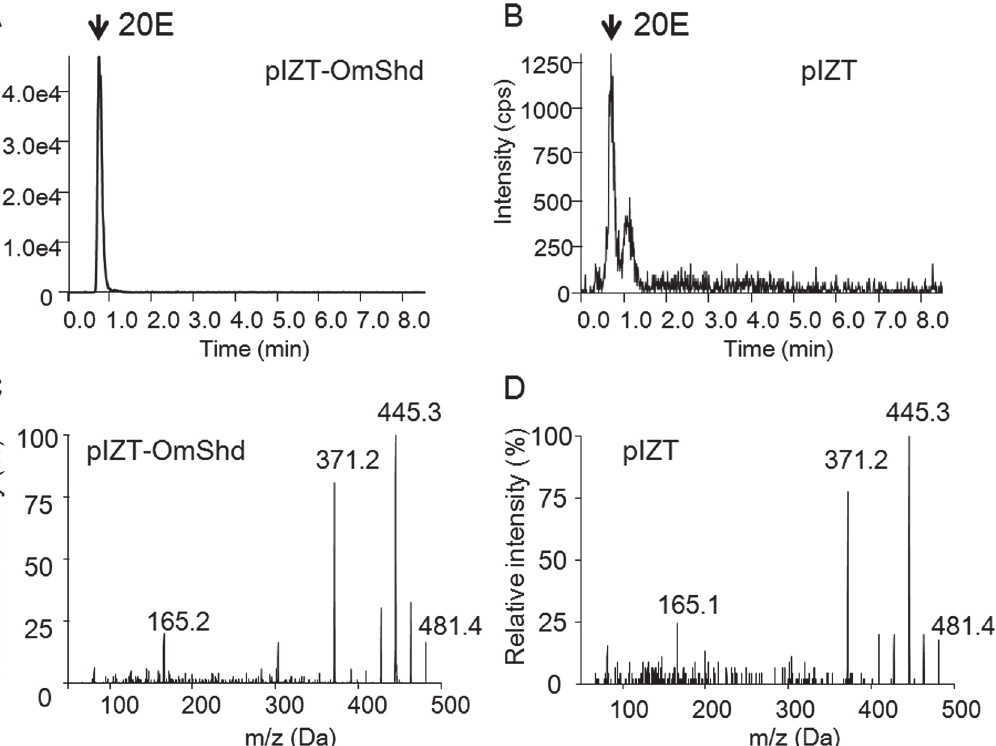
Fig 4. Chromatograms of 20-hydroxyecdysone (20E), produced by enzymatic assay of OmShd, analyzed with LC-MS/MS. 20E chromatograms from the medium of pIZT-OmShd vector (A) or pIZT vector (negative control) (B) were transfected to S2 cells. Intensity was indicated as counts per second (cps). MS/MS spectra of 20E standard (C) and 20E produced by OmShd (D).